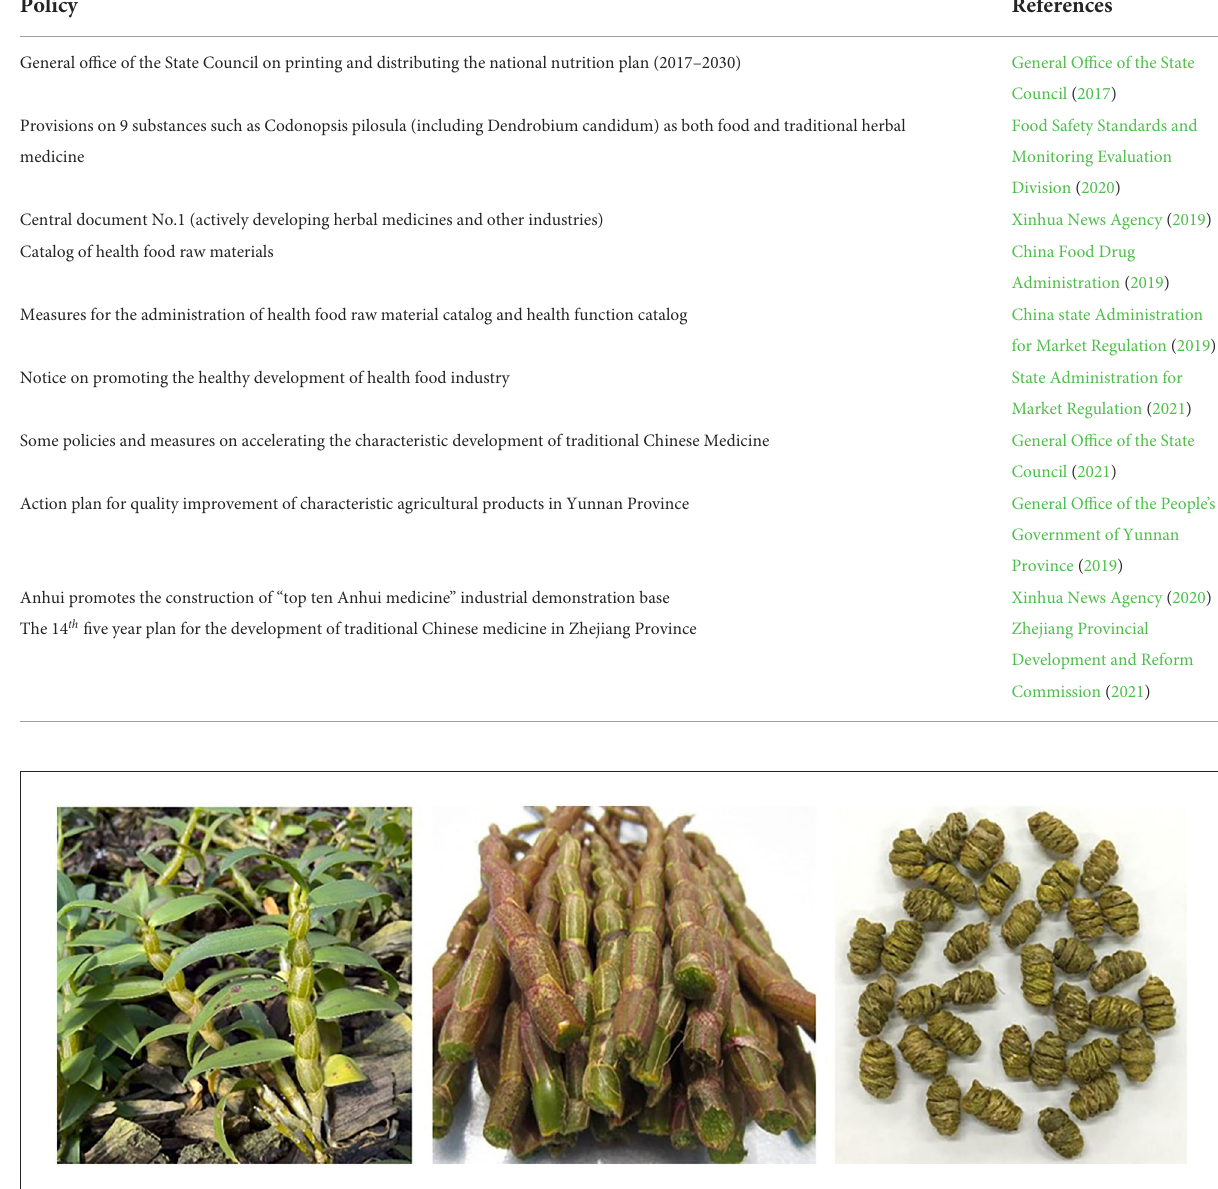
TABLE 1 Government policies for promote herbal medicine industry.